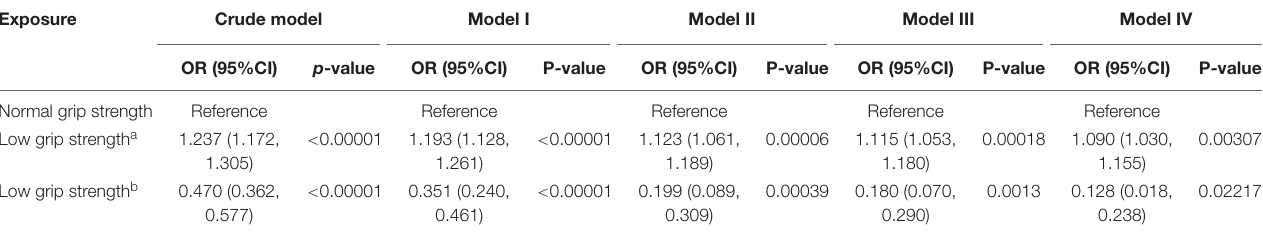
TABLE 1 | Multivariate regression model of the relationship between grip strength and the risk of